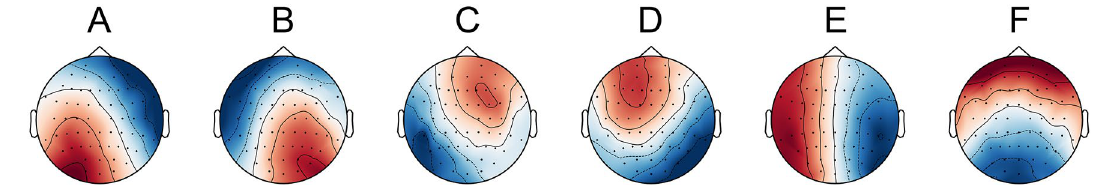
Figure 4. The topographies of six global microstate classes across runs, across participants, and across conditions. They are labelled and sorted according to Custo et al. 52 .